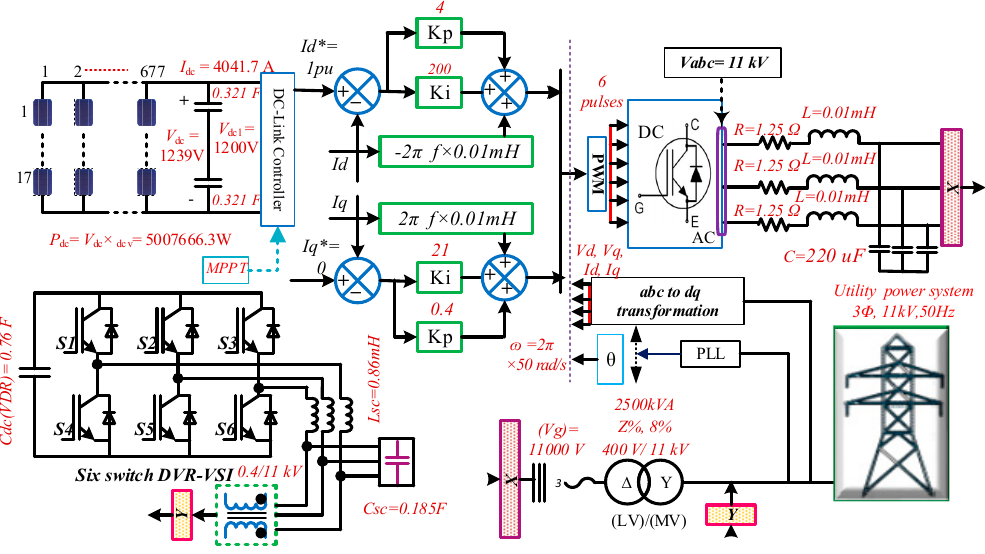
Figure 9. An overall system with DVR operation.